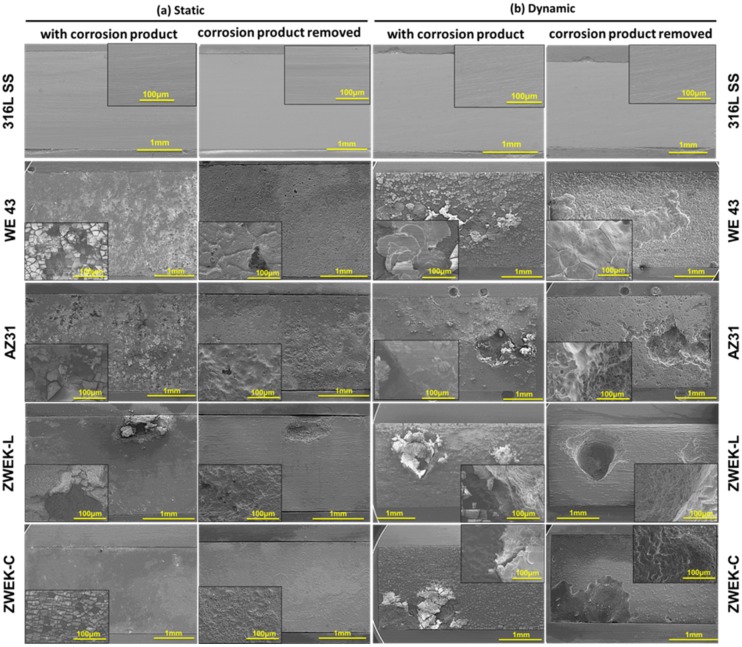
Surface images of corroded sample implants before and after removing corrosion products.The images display the surface morphologies at both static (a) and dynamic (b) conditions.